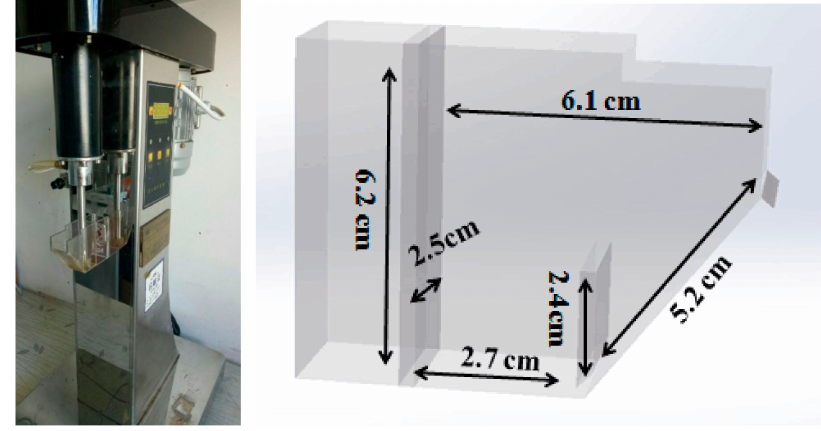
Figure 3. Geometry of flotation